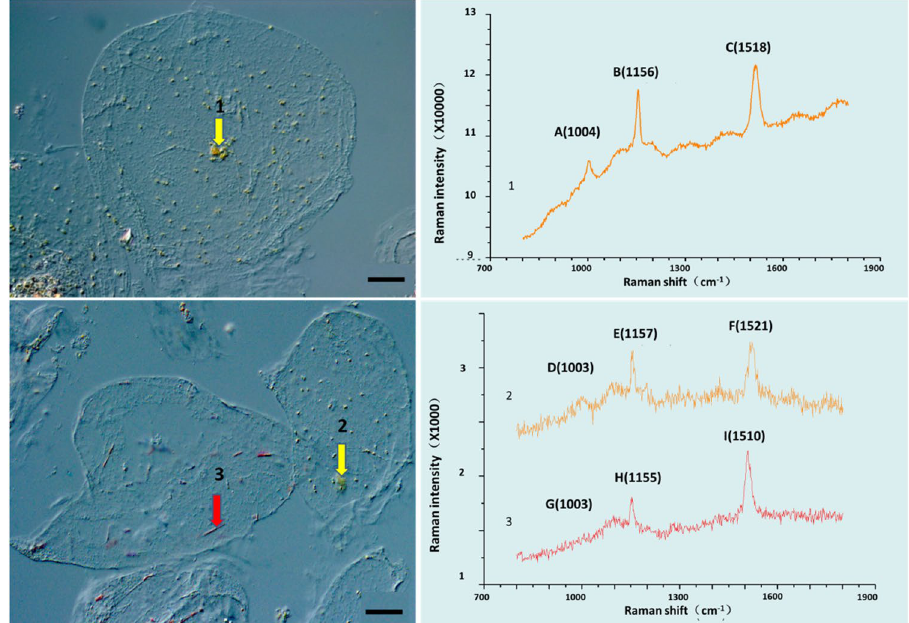
Figure 5. Raman microscope spectra of yellow globular chromoplast in Newhall (1), yellow globular chromoplast in Cara Cara (2), red crystalline chromoplast in Cara Cara (3). Bar, 50 μ m. Line 1, 2 represent carotenoids with 9 carbon-carbon double bond; Line 3 represent lycopene with unique 11 carbon-carbon double